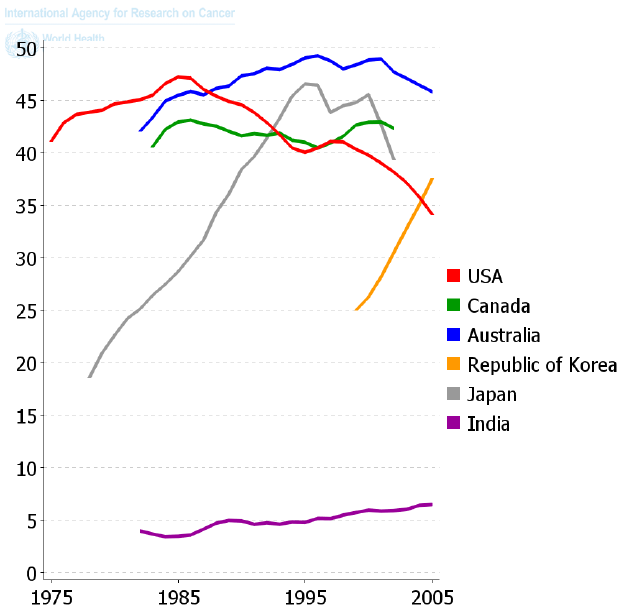
Figure 11. This figure illustrates the close correlation between the consumption of red meat and the frequency of colon cancer in different countries over 30 years. (The Y axis indicates frequencies of colon cancer per 100,000; the X axis indicates the years in which the frequencies were measured.) This clearly demonstrates, in the case of the Japanese and Korean incidences of colon cancer, that the “genetic background” of these two groups of people has little to do with the dramatic change in colon cancer. More likely, the changing diet in those countries is the driving force for the incidence of colon cancer. From: zur Hausen, [110]. Permission Granted.